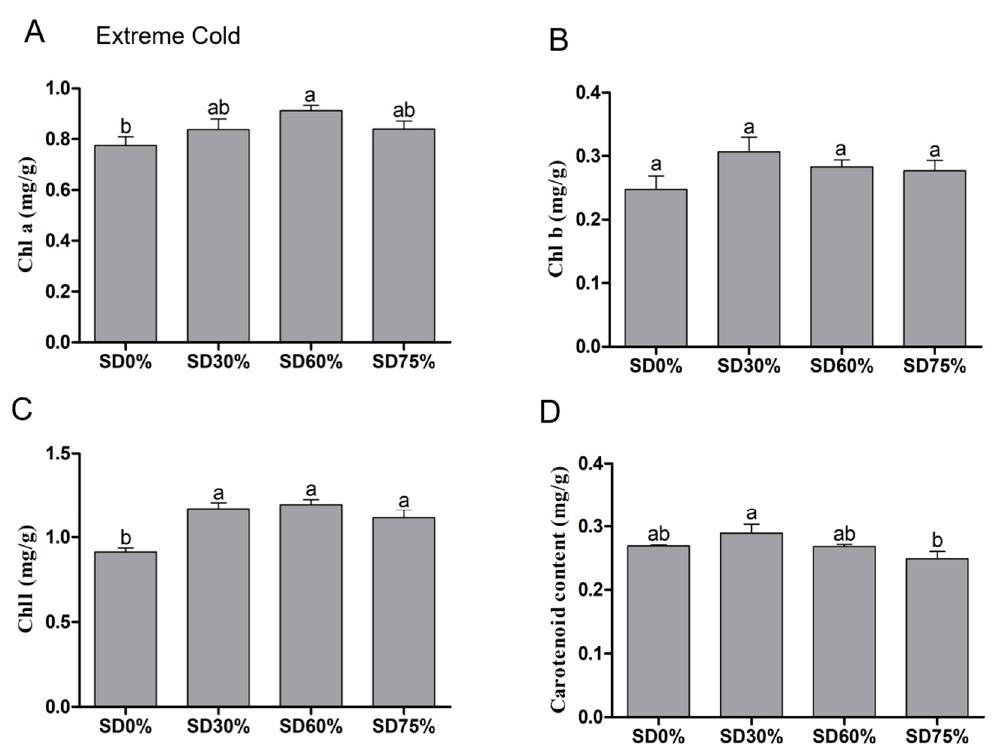
Figure 6. Effects of shading nets on ( A ) chlorophyll a, ( B ) chlorophyll b, ( C ) chlorophyll, and ( D ) carotenoid content during the extreme cold condition. Different letters on the top of the columns within each figure represent significant differences between the treatments indicated by LSD test at p < 0.05.